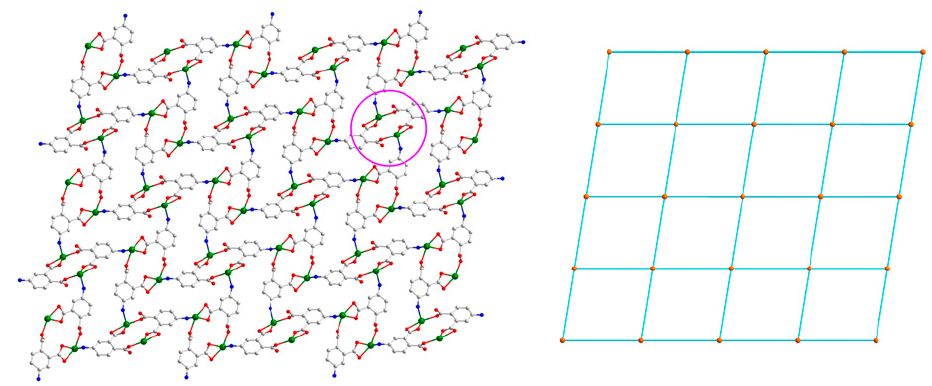
Figure 2. A 2D layer structure built from the Cd(II)(nobda) 2 − ( left ) in 1 and schematic representation of 2D network with (4, 4) topology ( right ).